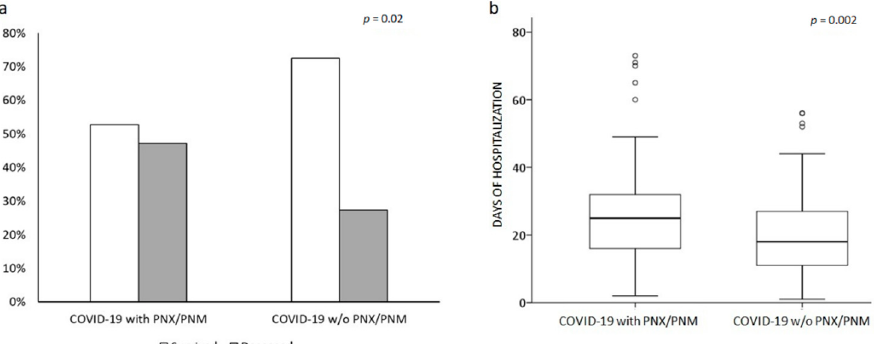
Figure 2. Comparison between COVID-19 patients with and w/o PNX/PNM. Bar line graph ( a ) compared the different in-hospital mortality rates (light grey deceased, dark grey survived) between the two groups. Box plot graph ( b ) compared the different lengths of hospitalization in the two groups. Solid line represents the median; bottom and top of the boxes are the 25th and 75th percentiles; brackets correspond to the 10th and the 90th percentiles.